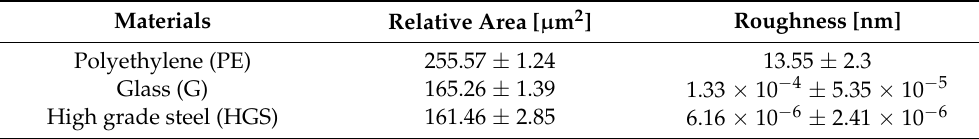
Table 2. Summary of the surface characteristics of the technical specimens.